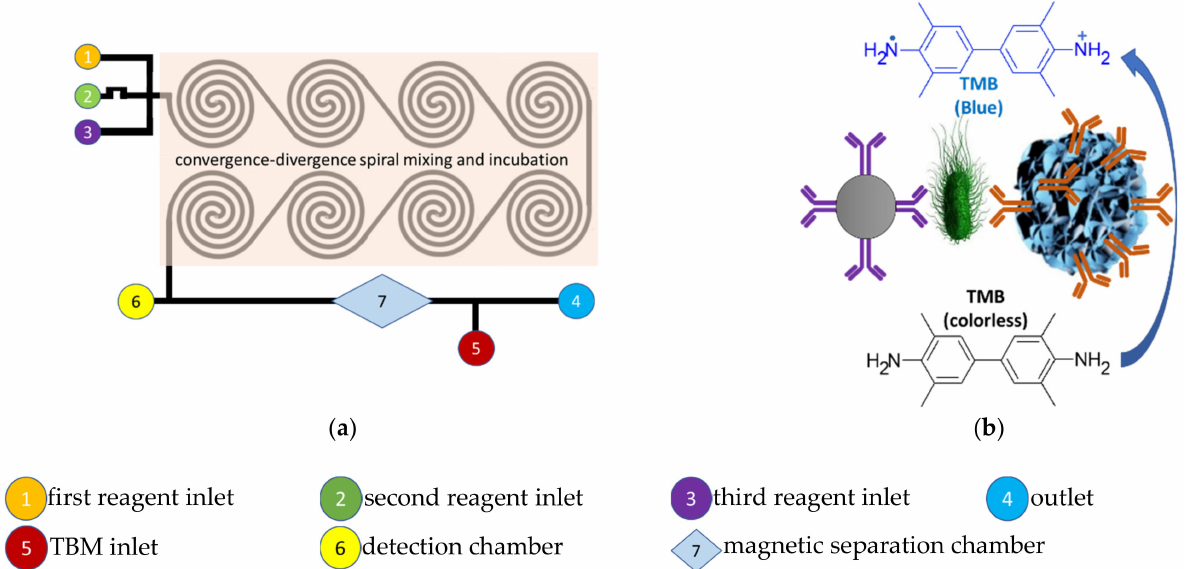
Figure 11. Illustrations of the nanozyme enhanced microfluidic system of Xue et al., (2021) [122]. ( a ) The nanozyme enhanced microfluidic system of Xue et al., (2021) with a single convergence- divergence mixing and incubation channel. ( b ) Sandwich type colorimetric nanozyme-linked im- munosorbent assay mechanism of the microfluidic system of Xue et al.,